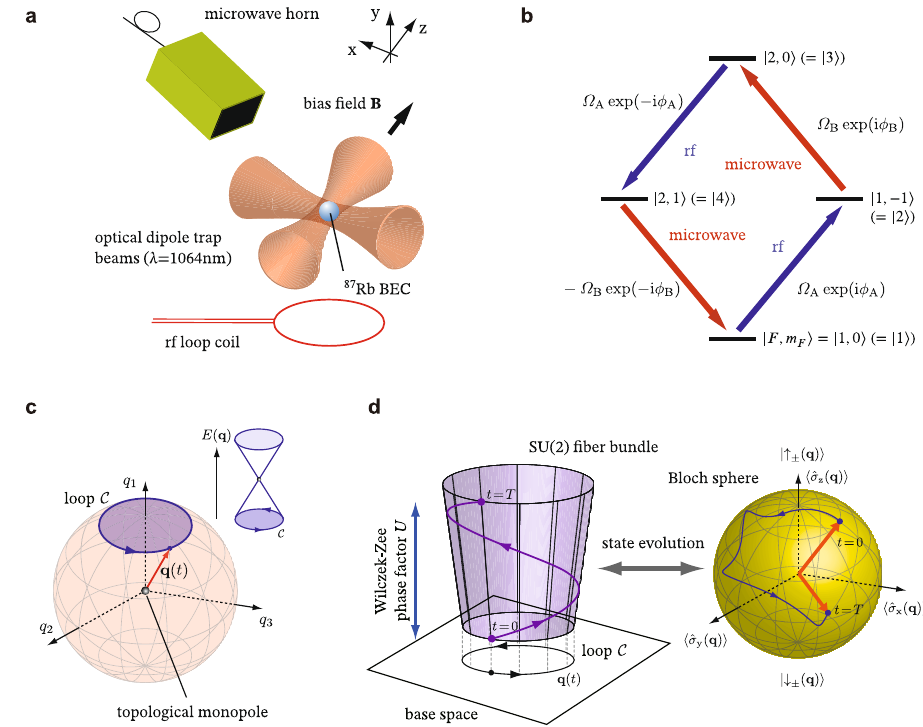
Fig. 1 Experimental and conceptual schematic. a Experimental setup. A 87 Rb BEC subject to uniform bias magnetic fi eld was illuminated with rf and microwave fi elds which coupled its hyper fi ne ground states. b Cyclically coupled four-level system realized with hyper fi ne ground states of 87 Rb. The total phase of the four complex coupling is π 33 . c W.-Z. phase measurement. A test particle encircling the Yang monopole along a path C acquires a W.-Z. phase. (inset) Energy landscape. The synthesized Yang monopole is a singularity at four-fold degenerate point, where the energy gap Δ E = 0. d Fiber-bundle description of the W.-Z. phase. Left: the vertical lift along the SU(2) fi ber bundle describes the W.-Z. phase. Right: The state evolution in our DS is represented by the trajectory of the Bloch vector. The fi nal state differs from the initial state by a factor of the